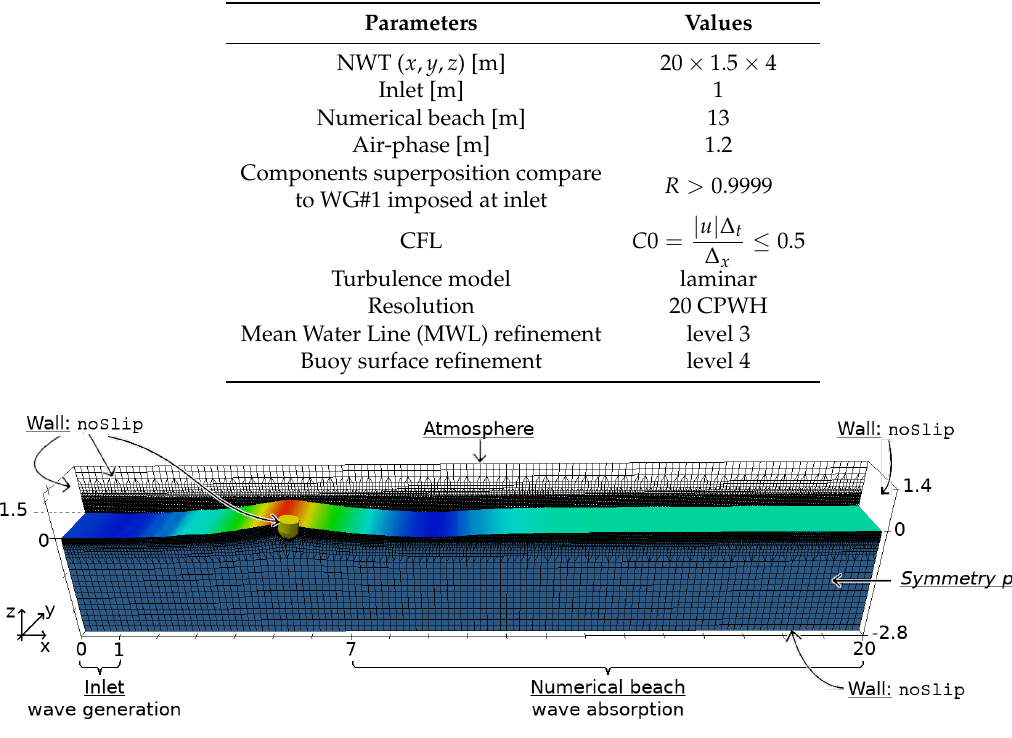
Figure 6. The 20 × 1.5 × 4m 3D-NWT developed for extreme WSI